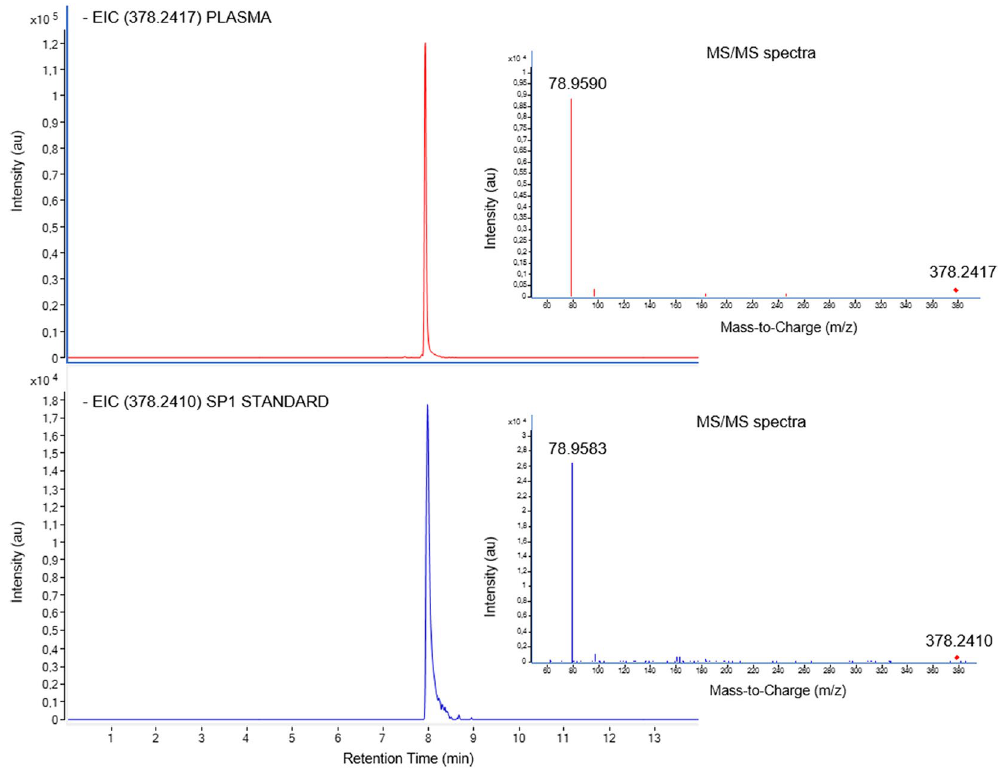
Figure 2. Confirmation of SP1 identity. Comparison of Extracted Ion Chromatogram (EIC) and MS/MS spectra (Collision energy = 20 eV) of SP1 in a plasma sample (m/z = 378.2410) and standard solution (m/z = 378.2410) at 1